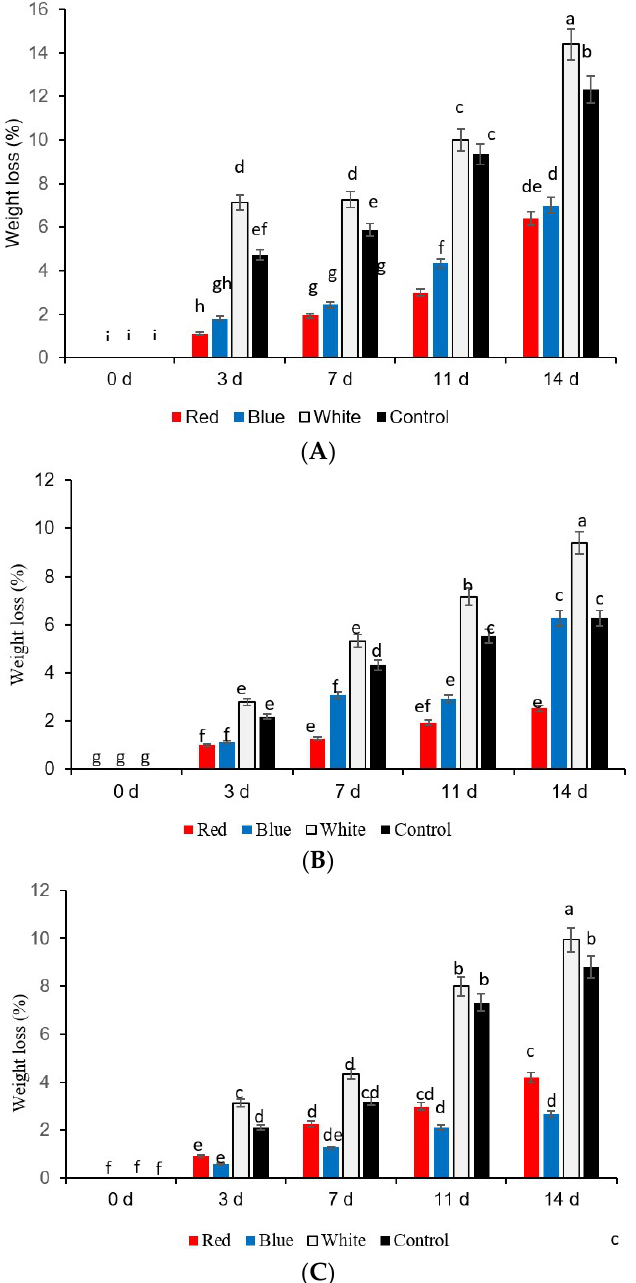
Figure 1. Effect of light-emitting diode (LED) treatments on weight loss of (A) yellow, (B) green, and Figure 1. E ff ect of light-emitting diode (LED) treatments on weight loss of ( A ) yellow, ( B ) green, and (C) red sweet pepper fresh-cuts. R— Red, B—Blue, W— White light; Control—Darkness. Data include ( C ) red sweet pepper fresh-cuts. R—Red, B—Blue, W—White light; Control—Darkness. Data include 0, 3, 7, 11, and 14 days storage time. Different letters above each bar indicate significant differences ( p 0, 3, 7, 11, and 14 days storage time. Di ff erent letters above each bar indicate significant di ff erences < 0.05) using Fisher’s Least Significant Difference (LSD) test. ( p < 0.05) using Fisher’s Least Significant Di ff erence (LSD)